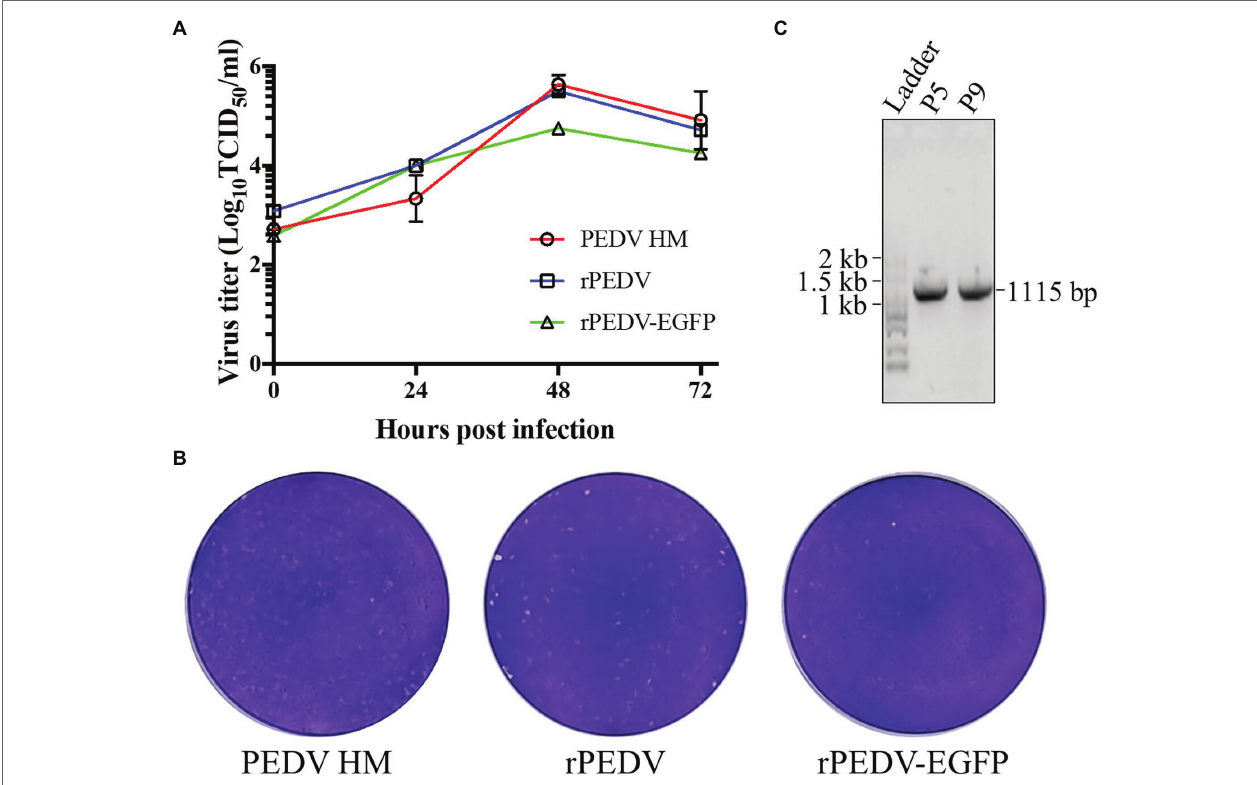
FIGURE 4 | In vitro characterization of the recombinant PEDV. (A) The multiple-step growth curves. Vero CCL-81 cells were inoculated with PEDV HM P12, rPEDV P5, or rPEDV-EGFP P5 at an MOI of 0.1. Culture supernatants were harvested at 0, 24, 48, 72 hpi and titrated by TCID 50 . Each data point represents the mean value of two replicates with SD. (B) Plaque assay. The confluent Vero CCL-81 cells were infected with 10-fold diluted PEDV HM, rPEDV, or rPEDV-EGFP, respectively. Cells were overlaid with 5 ml of DMEM containing 1% UltraPure ™ Low Melting Point Agarose (Thermo Fisher Scientific) and 10 μ g/ml trypsin (Thermo Fisher Scientific). At 3 dpi, plaques were visualized by 0.1% crystal violet staining. (C) The stability of the EGFP gene in rPEDV-EGFP during in vitro passages. To this end, rPEDV-EGFP was serially passaged nine times in Vero CCL-81 cells. Viral RNAs of P5 and P9 were extracted and used for RT-PCR amplification of genomic regions containing the EGFP gene. The amplicons were separated in 1% agarose gel, and their expected size is 1,115 bp. DNA sequencing was conducted to confirm their sequences.